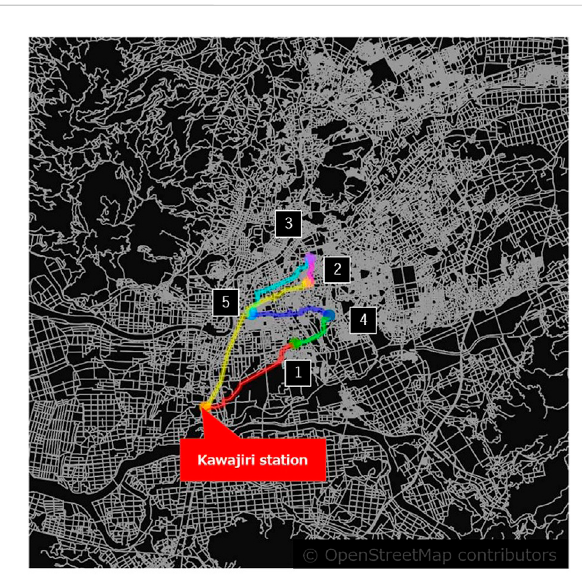
FIGURE 5 Route visualization for the break solution in instance No. 9 of the basecase(pathsarerepresentedbyred,green,blue,lightblue,purple, and yellow in that